Question: Write a caption explaining this figure to a reader.
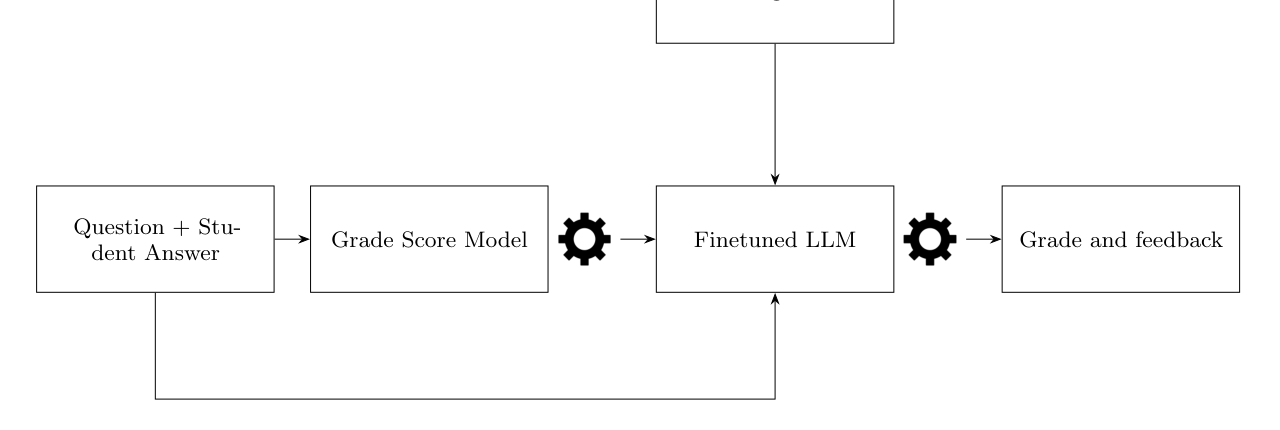
Answer: An overview of our most performant models in terms of grading scores and grading feedback. Assessment questions, student answers, and grading rubrics are supplied as inputs to our grade score and feedback generation models. The grade score model outputs are supplied as input to our finetuned LLMs leading to higher performance. A highly accurate, w.r.t. domain expert ground-truth, grade score and feedback is outputted.